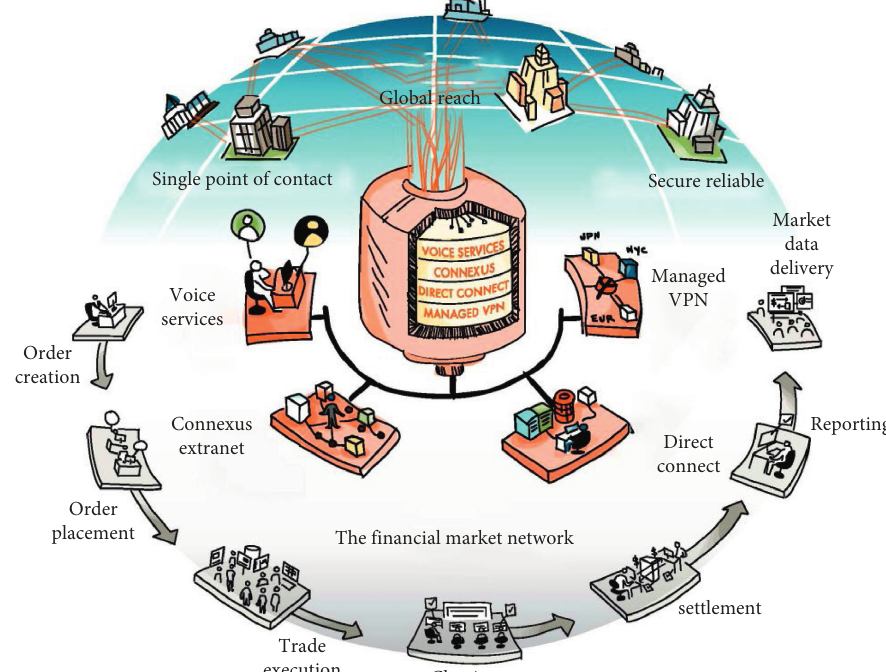
Figure 3: Interactive network of financial market